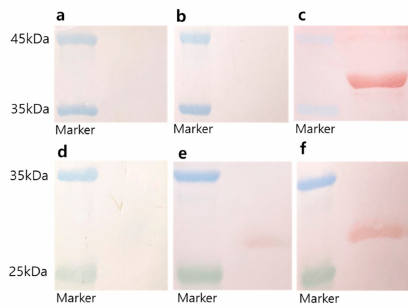
Figure 5. Western blot analysis of serum samples from each group of immunized mice. ( a – c ) rVP1 (approximately 37 kDa) and ( d – f ) rVP3 protein (approximately 26 kDa)-blotted membranes treated with the diluted sera (1:100) obtained from mice immunized with ( a , d ) PBS (control), ( b , e ) m-peptide, and ( c , f ) m-PA. Red bands indicate rVP1 or rVP3 proteins that reacted with the serum. Blue bands are markers for 45 and 35 kDa, while green bands are the marker for 25